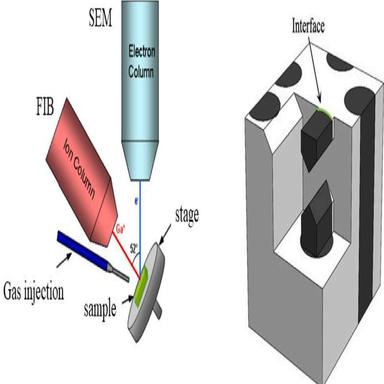
SEM image of a ready to be tested micro-cantilever beam.